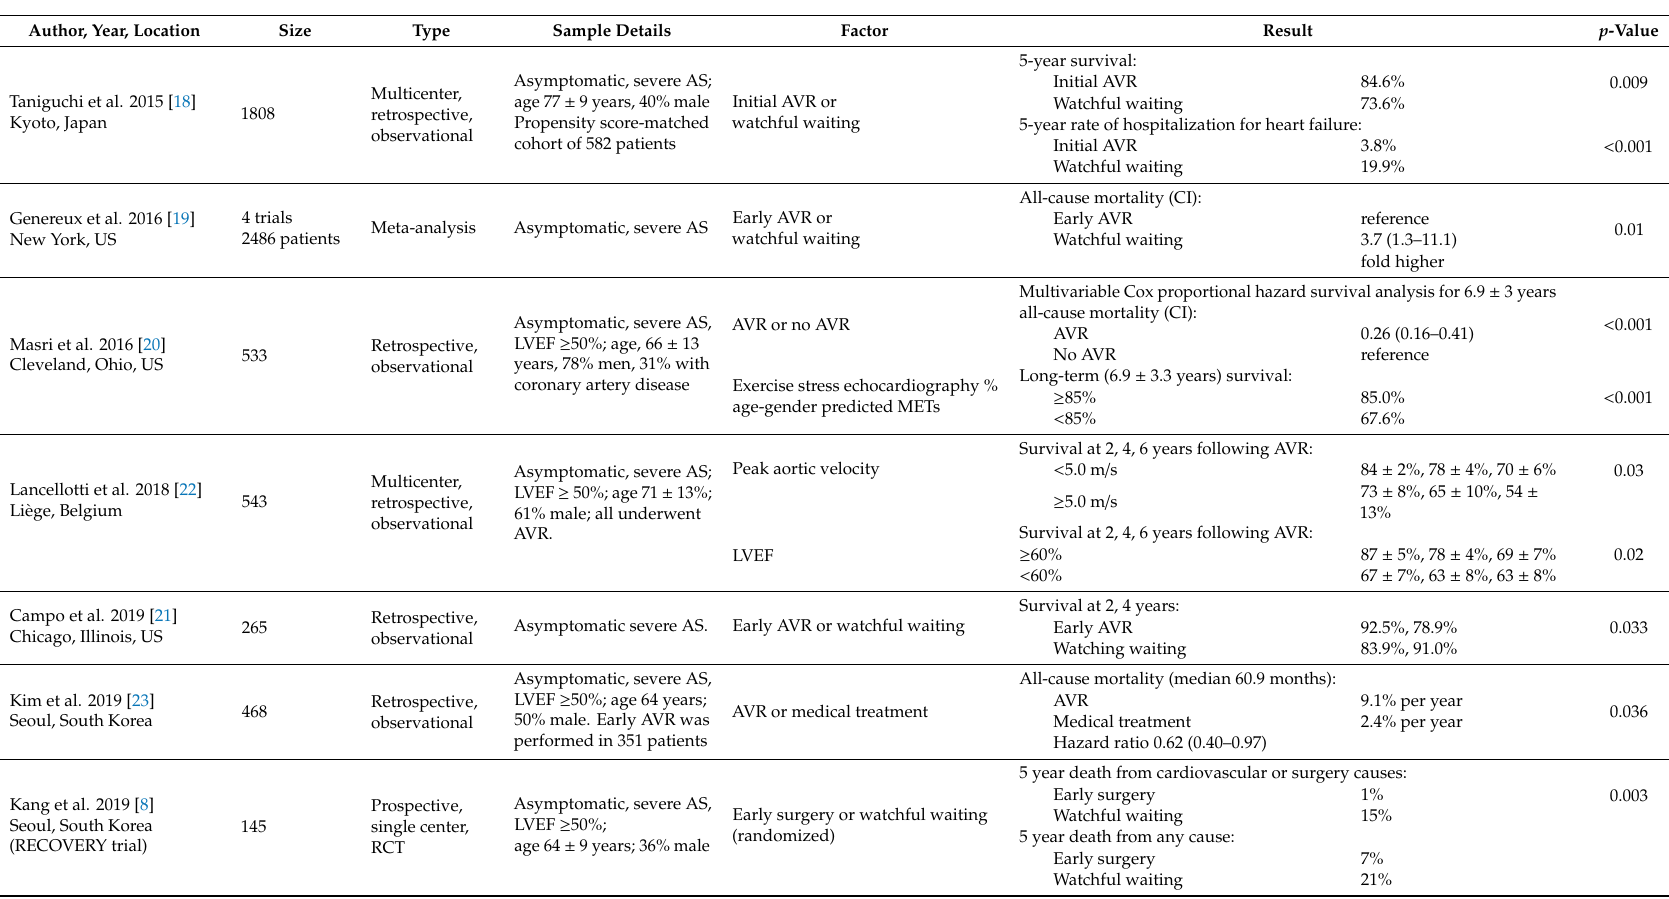
Table 4. Summary of studies that examine the timing of aortic valve surgery for chronic AS which were published subsequent to the release of the AHA / ACC 2014